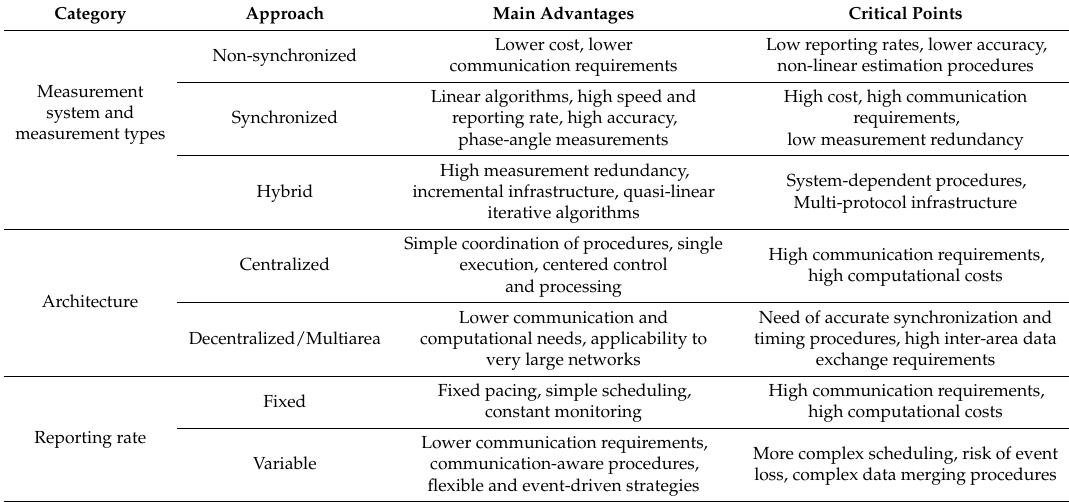
Table 1. Main aspects in DSSE